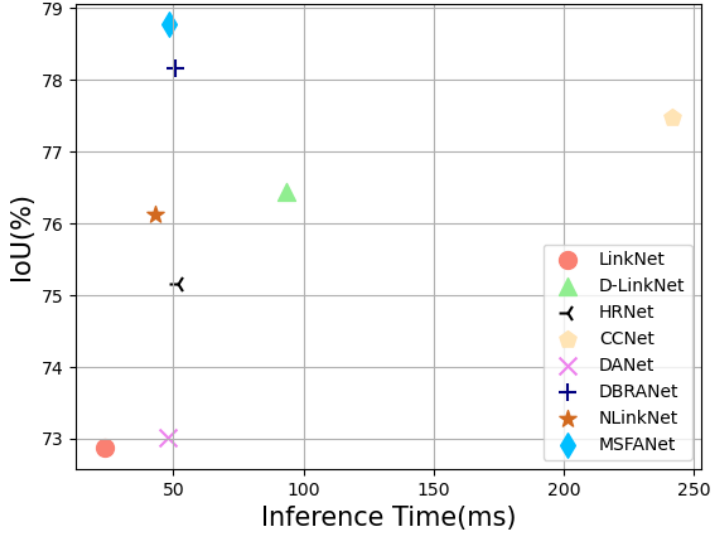
Figure 15. The inference time and IoU of each network.